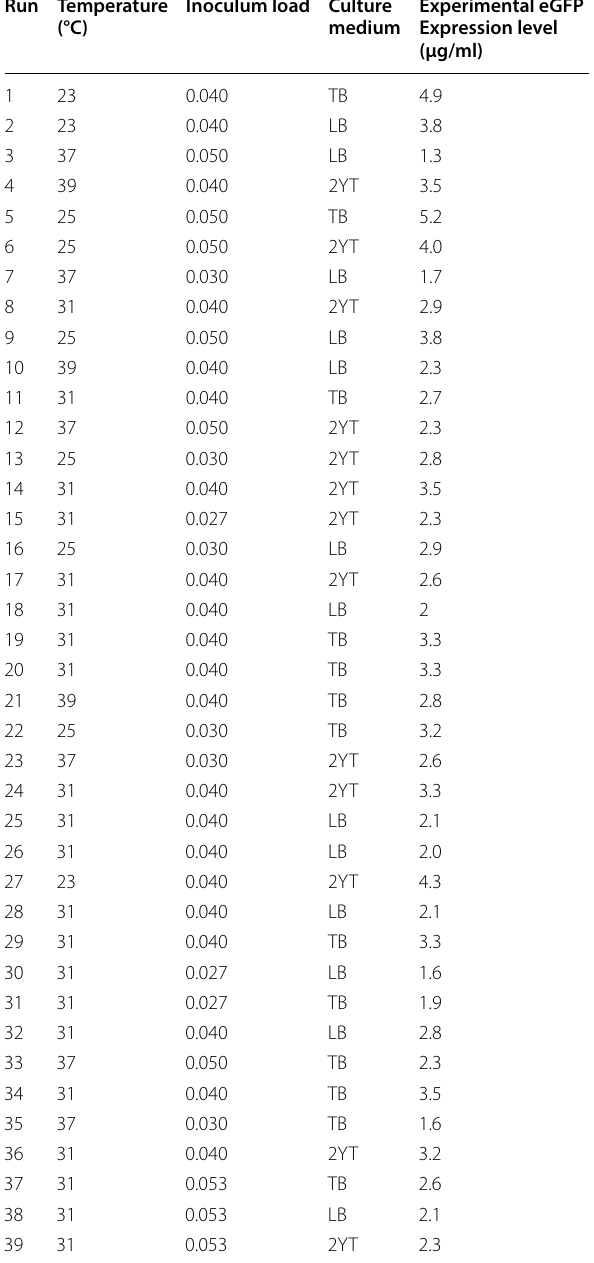
Table 1 The designed experiments for indirect optimization of SAK expression as a response